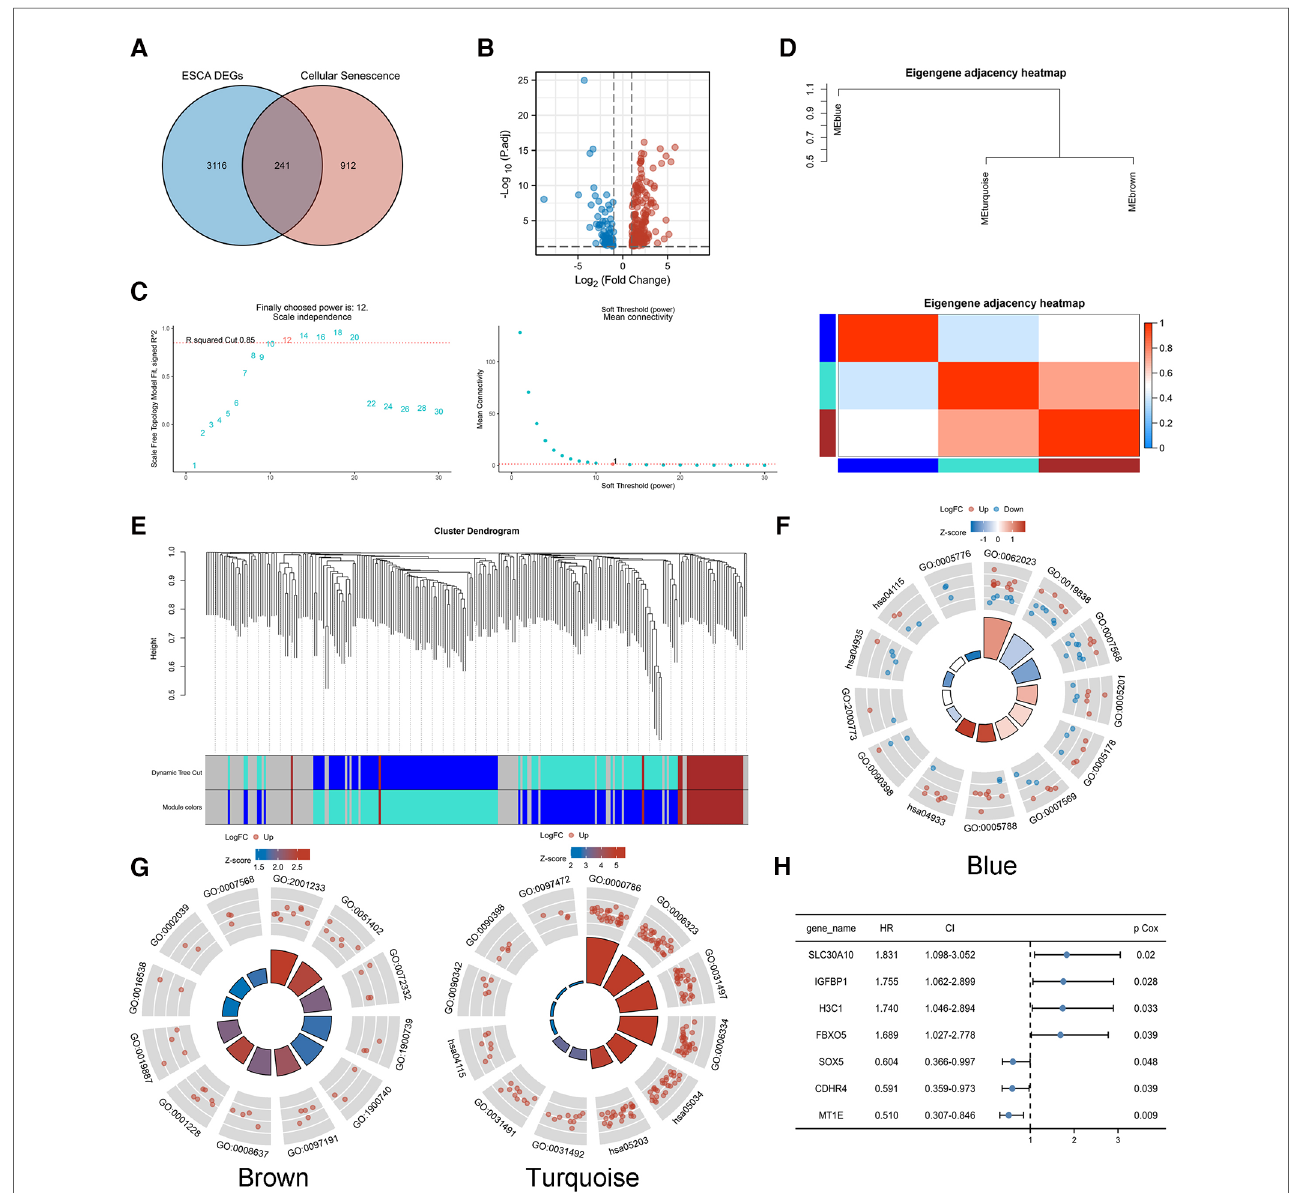
FIGURE 2 Identi fi cation of CS-related prognostic genes. ( A,B ) A total of 241 genes were differentially expressed between EC and normal tissues(|log2FC|>1, p <0.05). ( C ) Soft threshold β of WGCNA was determined as 12 based on the scale-free fi t and the mean connectivity. ( D – E ) WGCNA network classi fi ed the CS- related DEGs into three different modules, blue, brown and turquoise. GO/KEGG analysis was performed in module genes. ( F ) Blue module. ( G ) Brown and turquoise modules. ( H ) Univariate COX regression analysis of modular